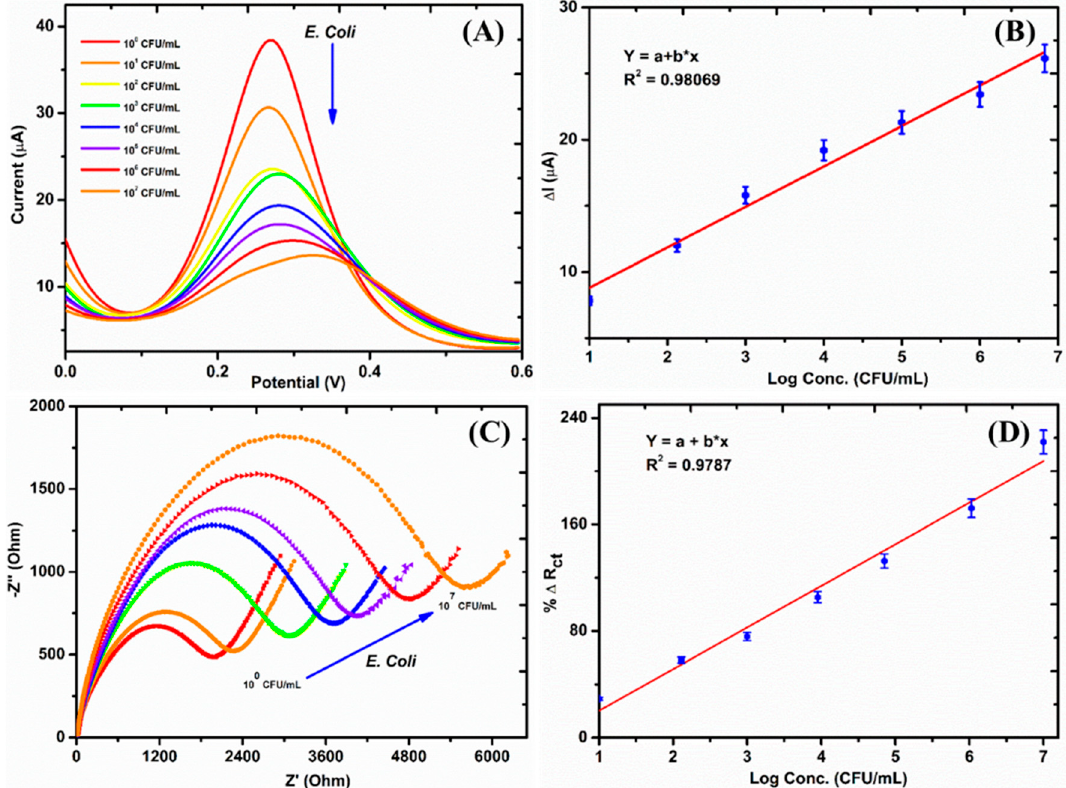
Figure 7. ( A ) Change in the DPV spectra of biosensor in the presence of E. coli in 5 mM of [Fe(CN) 6 ] 3 − /4 − , 0.1 M of KCl, and 100 mM PBS buffer (pH = 7.4). ( B ) Calibration plot between changes in current to concentration of E. coli ; ( C ) Nyquist plot of the biosensor in the presence of E. coli in 5 mM of [Fe(CN) 6 ] 3 − /4 − , 0.1 M of KCl, and 100 mM PBS buffer (pH = 7.4). ( D ) Percentage change in charge transfer resistance ( R ct ) in the presence of E. coli .